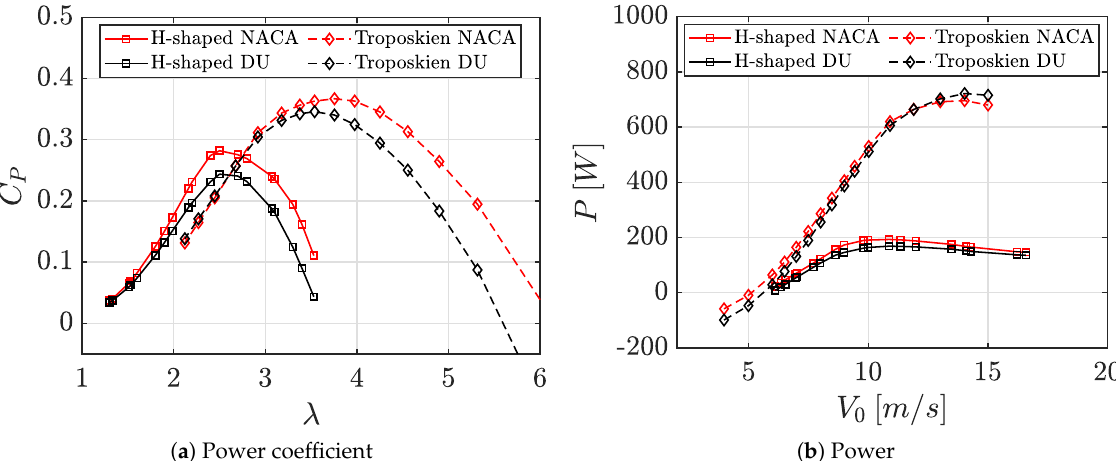
Figure 11. Sensitivity analysis to airfoil shapes: NACA0021 and DU06W200 for the case of micro H-shaped 200 W and Troposkein 800 W rotors.